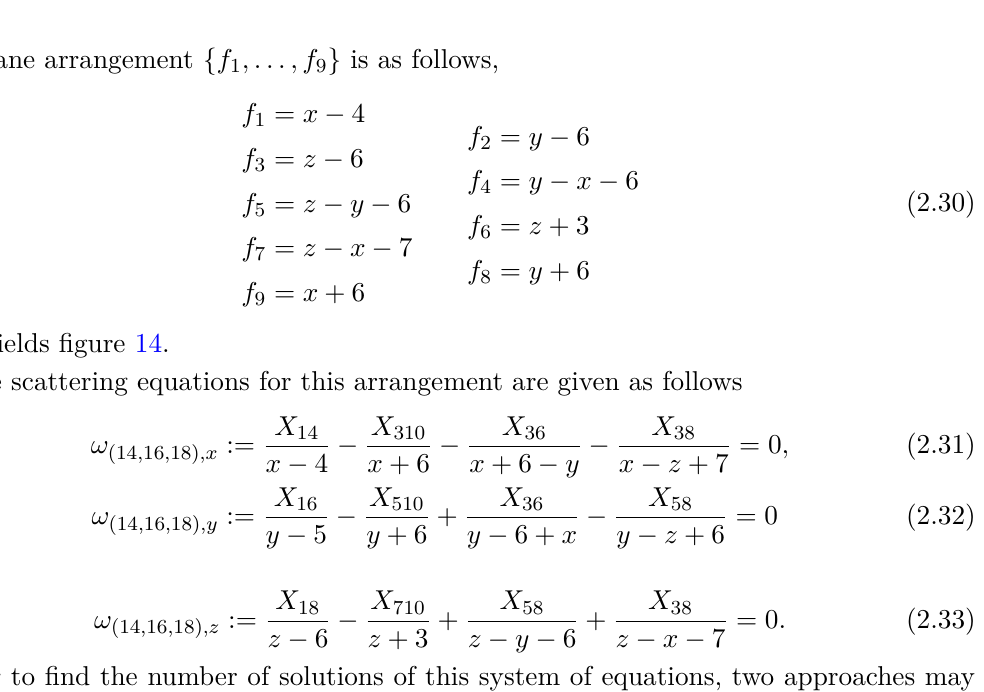
Figure 14 . Accordiohedron for dissection (14 , 16 , 18)